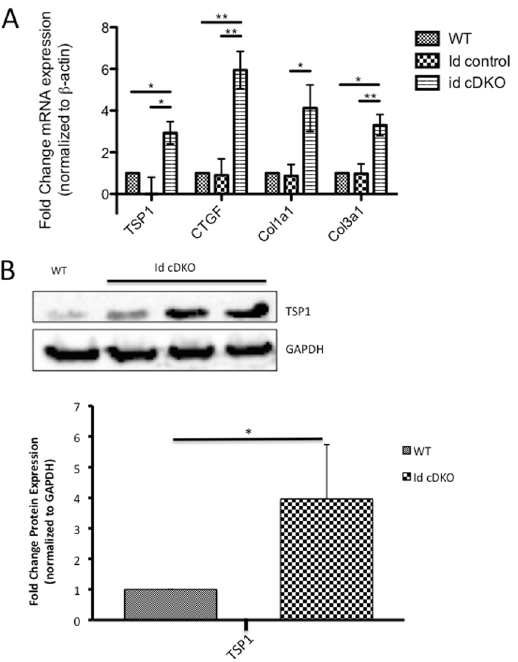
Figure 1. Activation of TSP1/CTGF/collagen in Id cDKO hearts. ( A ) RT PCR analysis of WT (n = 3), Id control (n = 6) and Id cDKO (n = 6) hearts between 5–6 months of age. mRNA expression normalized to β -actin. A one-way ANOVA was used to test for differences in mRNA expression amongst the three groups. Data presented as fold change relative to WT levels. mRNA levels were significantly different across the three group for the following markers: Thrombospondin-1 (TSP1): F (2, 12) = 6.12, p = 0.01; connective tissue growth factor (CTGF): F (2, 12) = 11.05, p = 0.002; collagen I (Col1a1): F (2, 12) = 4.07, p = 0.04; collagen III (Col3a1): F (2, 12) = 6.07, p = 0.02. * p < 0.05; ** p < 0.01 ( B ) Representative western blot for TSP1 in 6 month old WT and